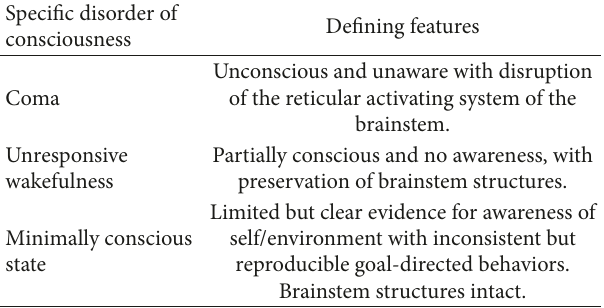
Table 4: Primary classifications for disorders of